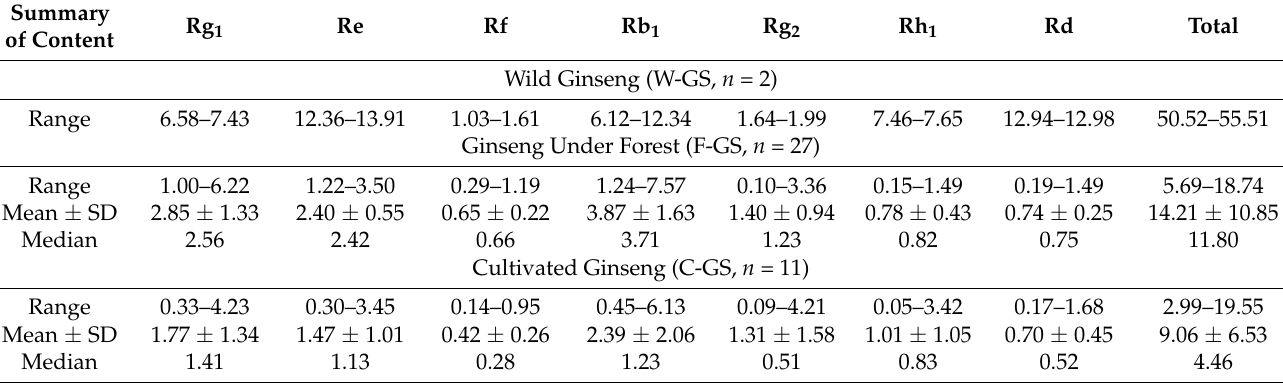
Table 4. Mean, median and range of seven ginsenosides’ contents (mg/g) in three types of ginseng